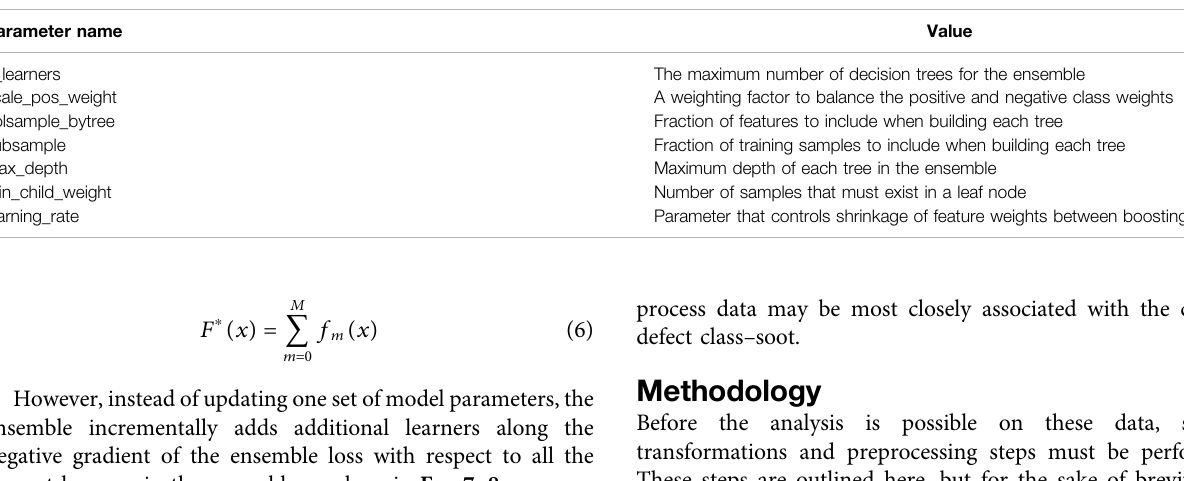
TABLE 3 | Description of a subset of XGBoost model